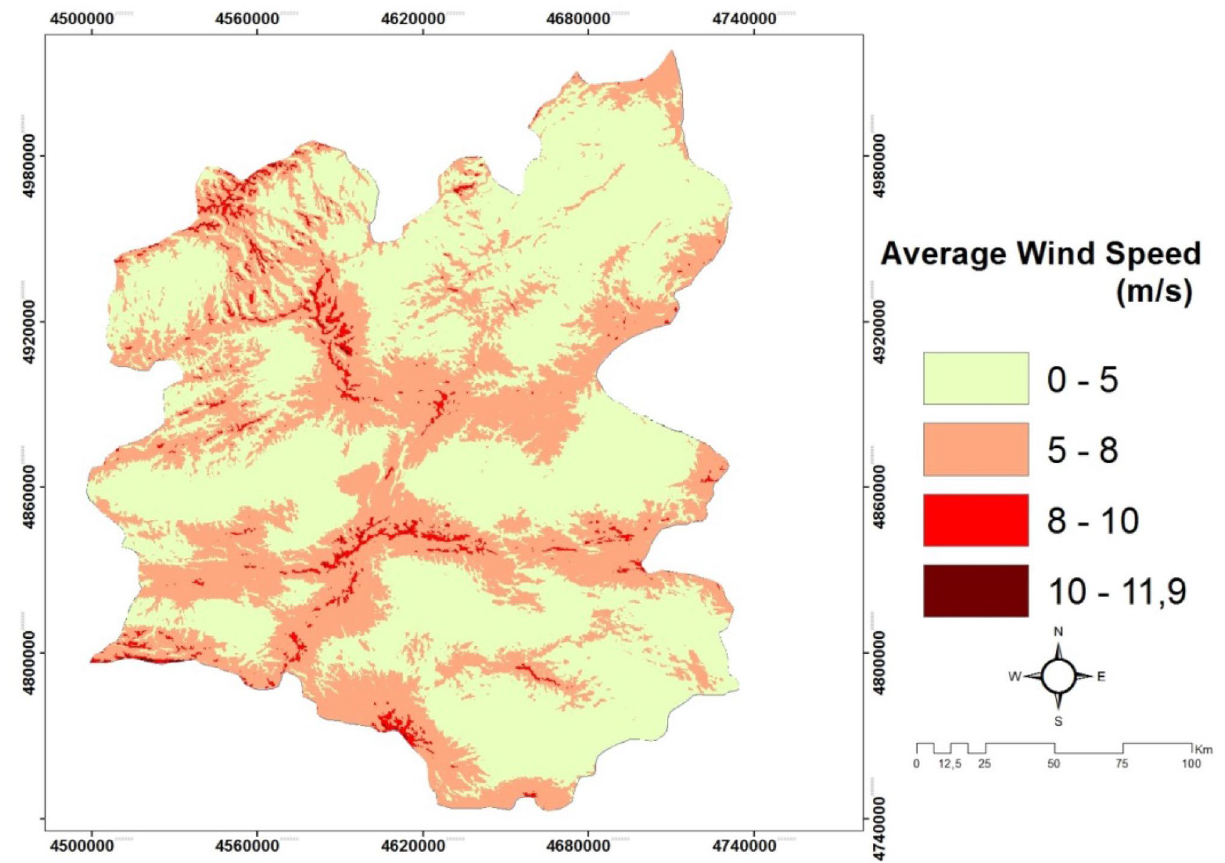
Figure 7. The average wind speed of